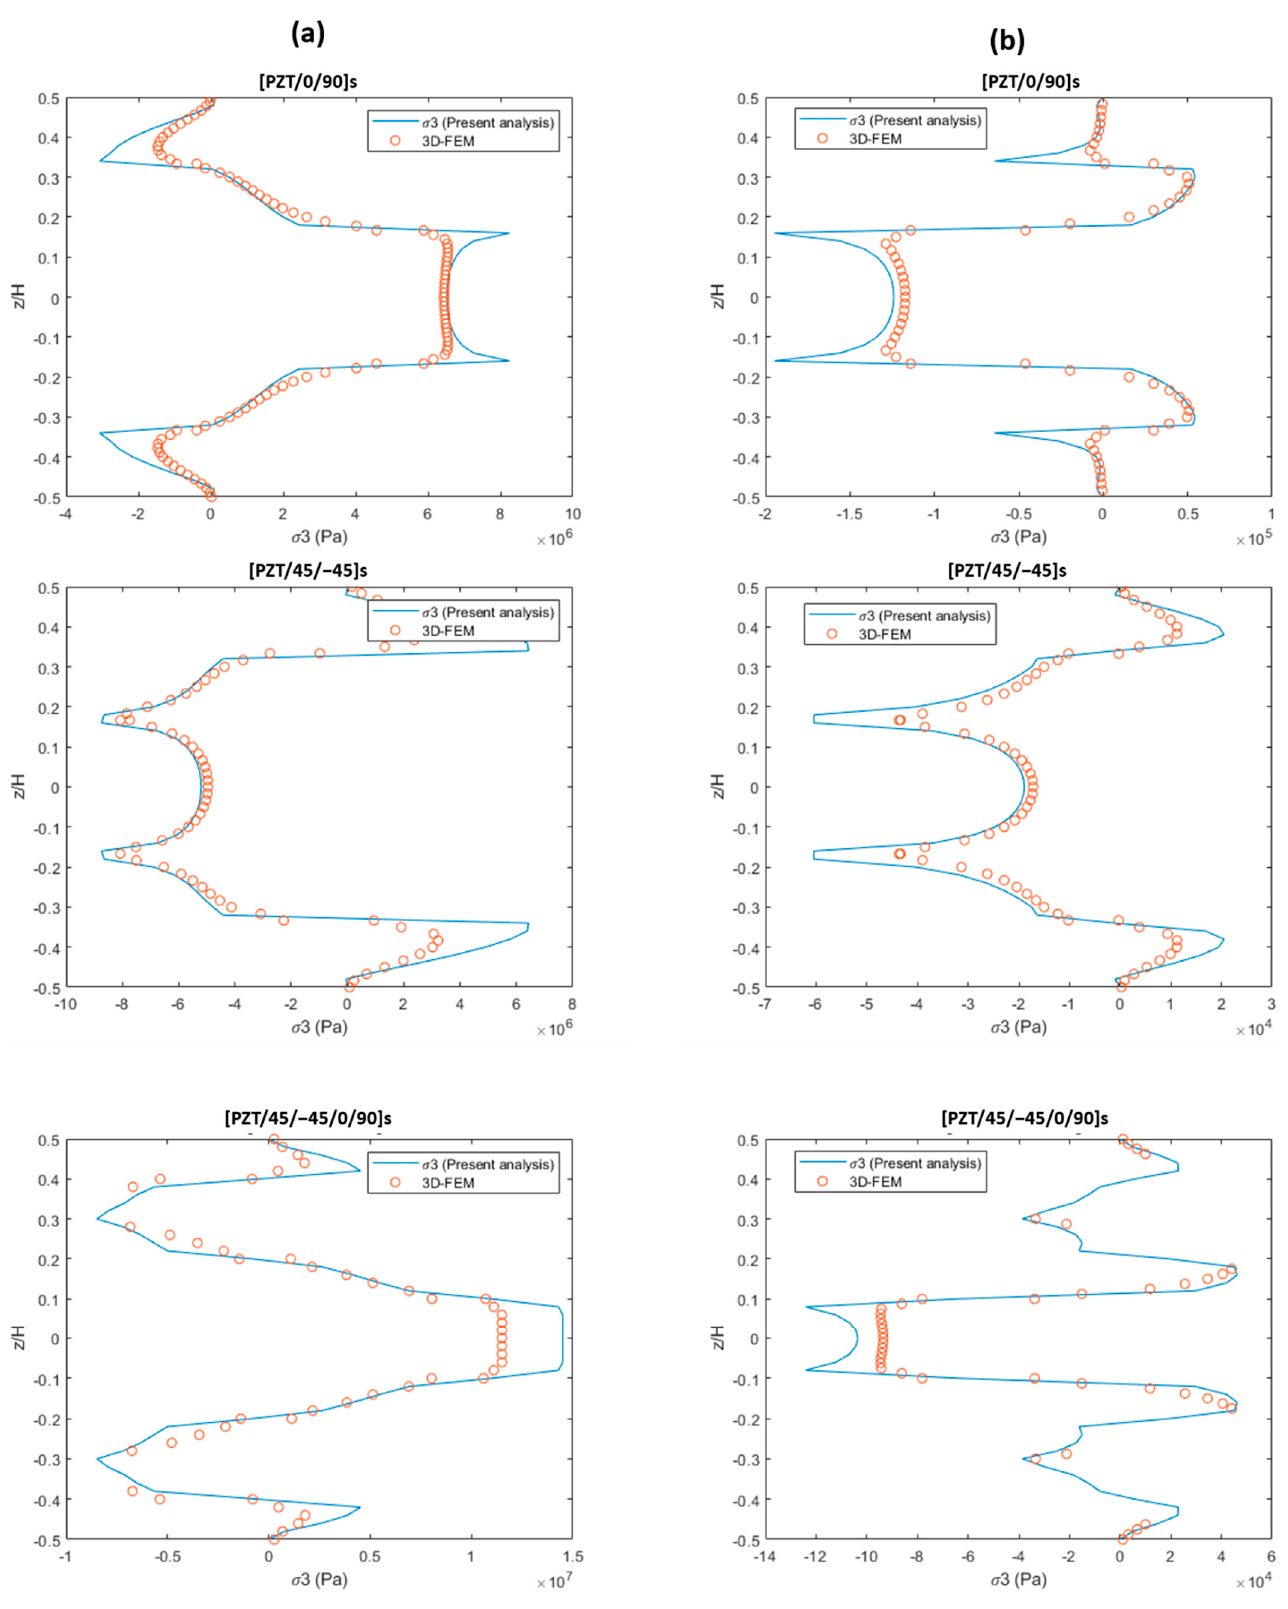
Figure 3. Free-edge interlaminar stress distribution in cross-ply, angle-ply, and quasi-isotropic layups ( a ) under 0.1% uniaxial extension loading and ( b ) under unit thermal loading ( Δ T = 1).